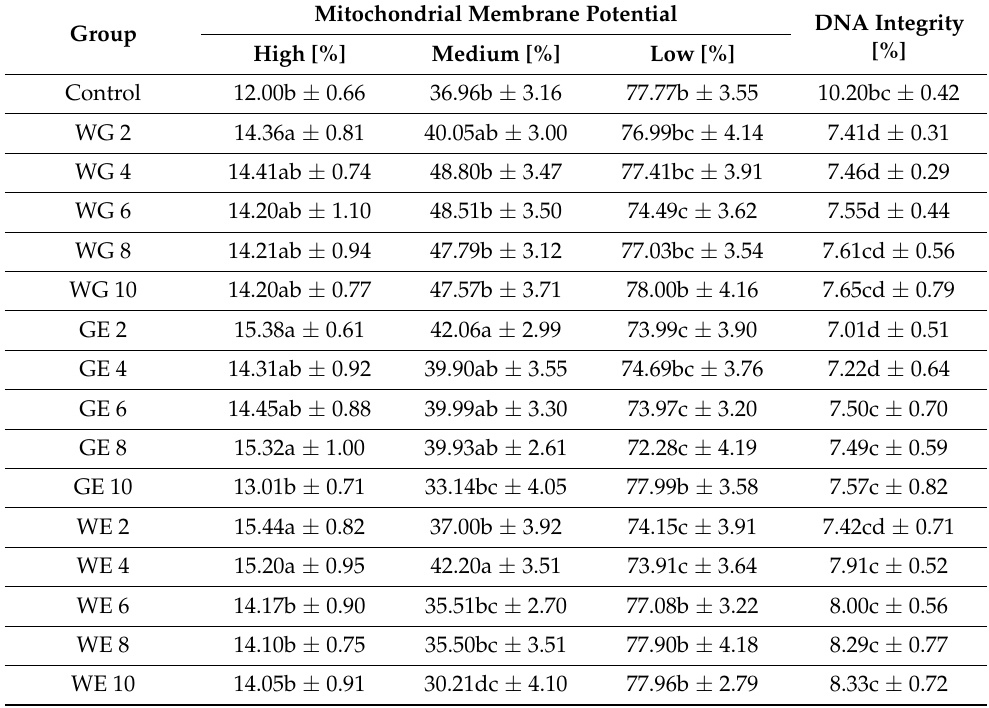
Table 4. Effect of various types of sea cucumber extract on the mitochondrial membrane potential and DNA integrity of sperm after cryopreservation. Explanations: a–e—means with different superscript letters in the same column differ significantly at p <